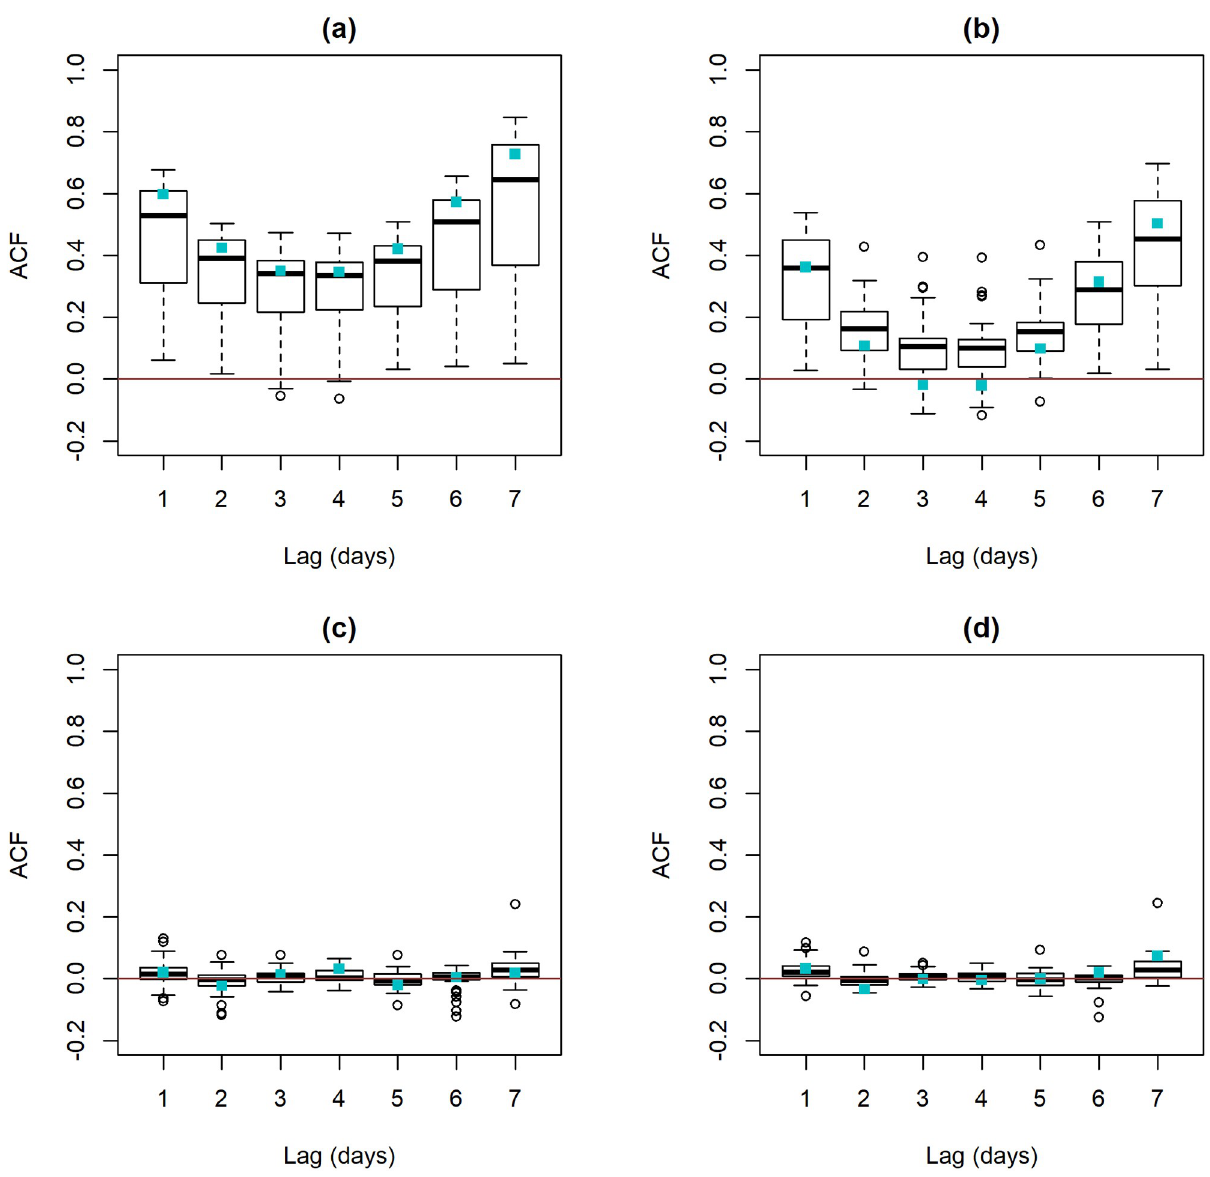
Fig 8. Boxplot of sample ACF values calculated at each location. (a) the time series of counts with daily hospital admissions, (b) residuals of the M R models, (c) residuals of the pure INGARCH M I models and (d) residuals of M F models. The blue squares identify the sample ACF values for Valongo (VALO)